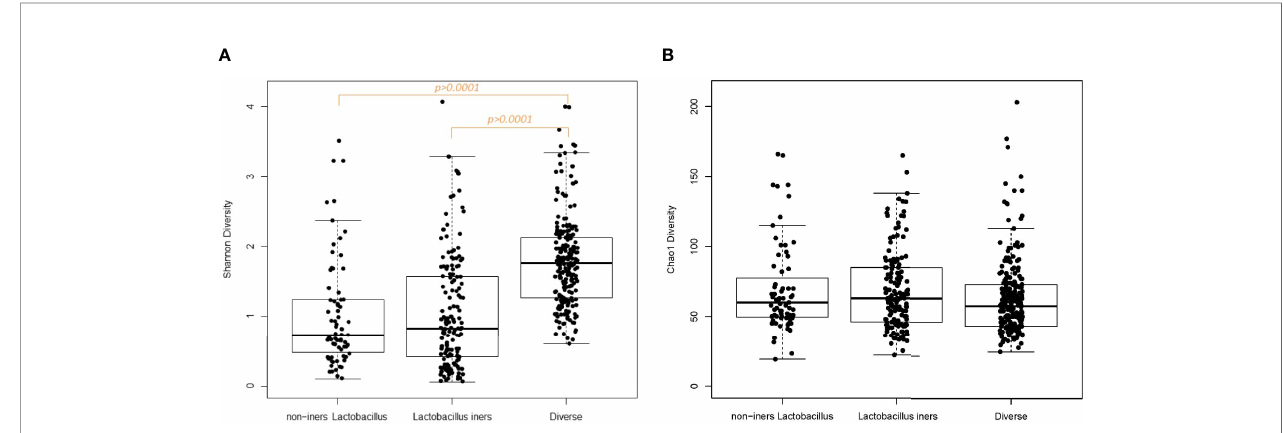
FIGURE 1 | (A) Box plot Shannon diversity according to CST category. (B) Box plot of Chao1 diversity according to CST